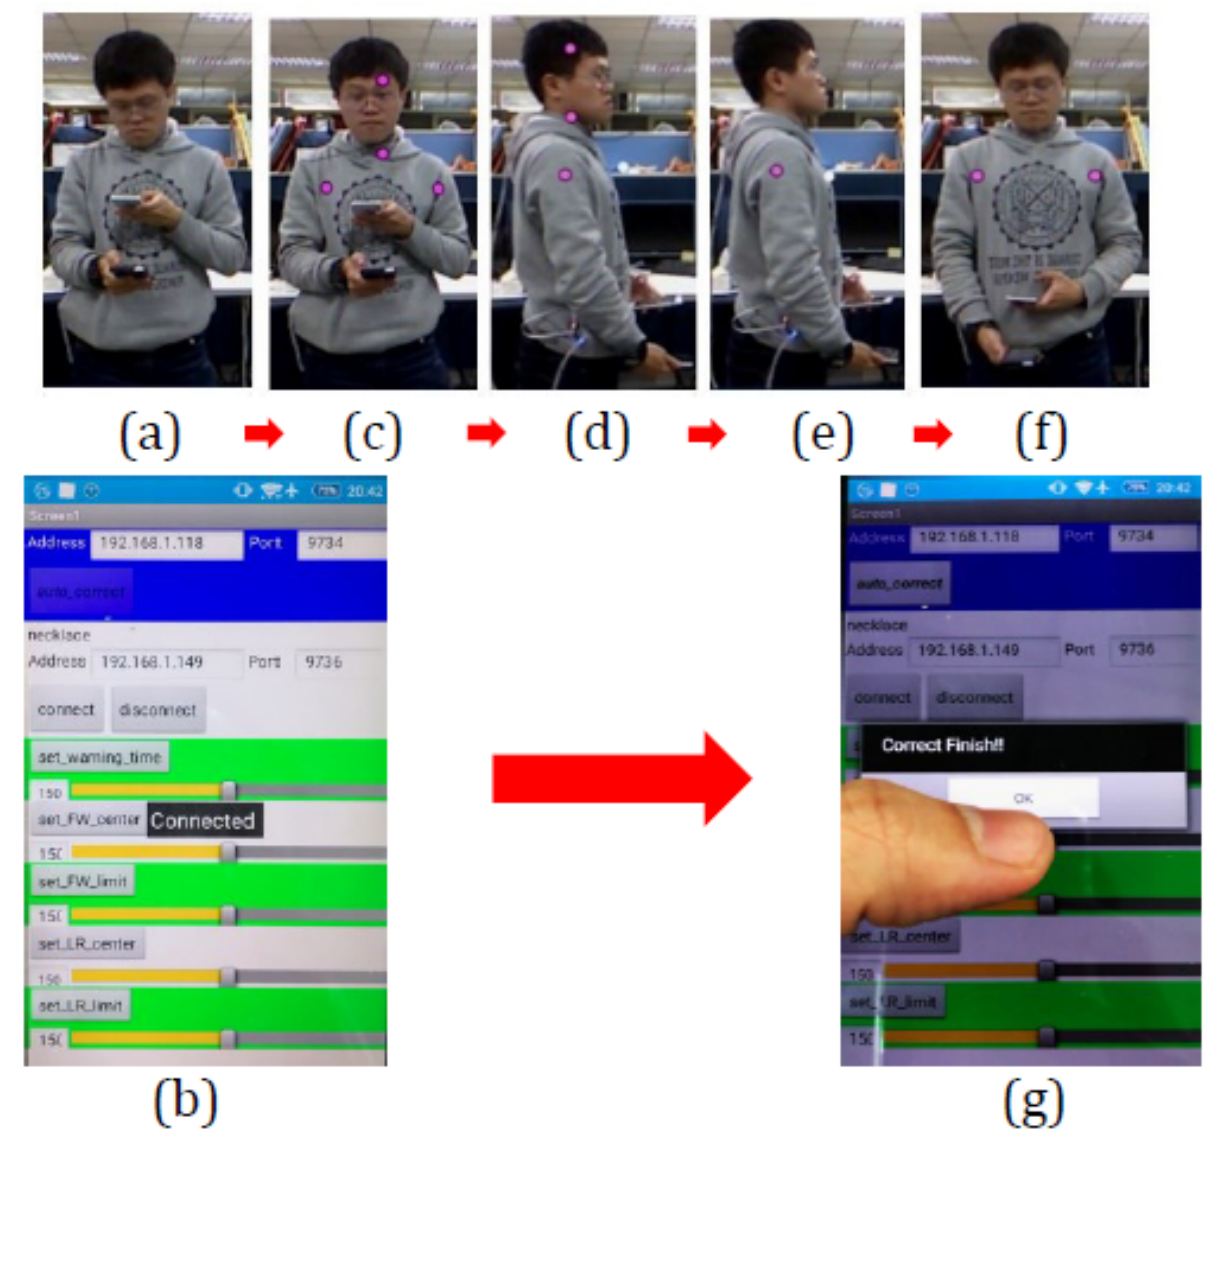
Figure 16. Program that utilizes the notebook computer's image recognition function to perform an automatic calibration of the smart necklace's internal